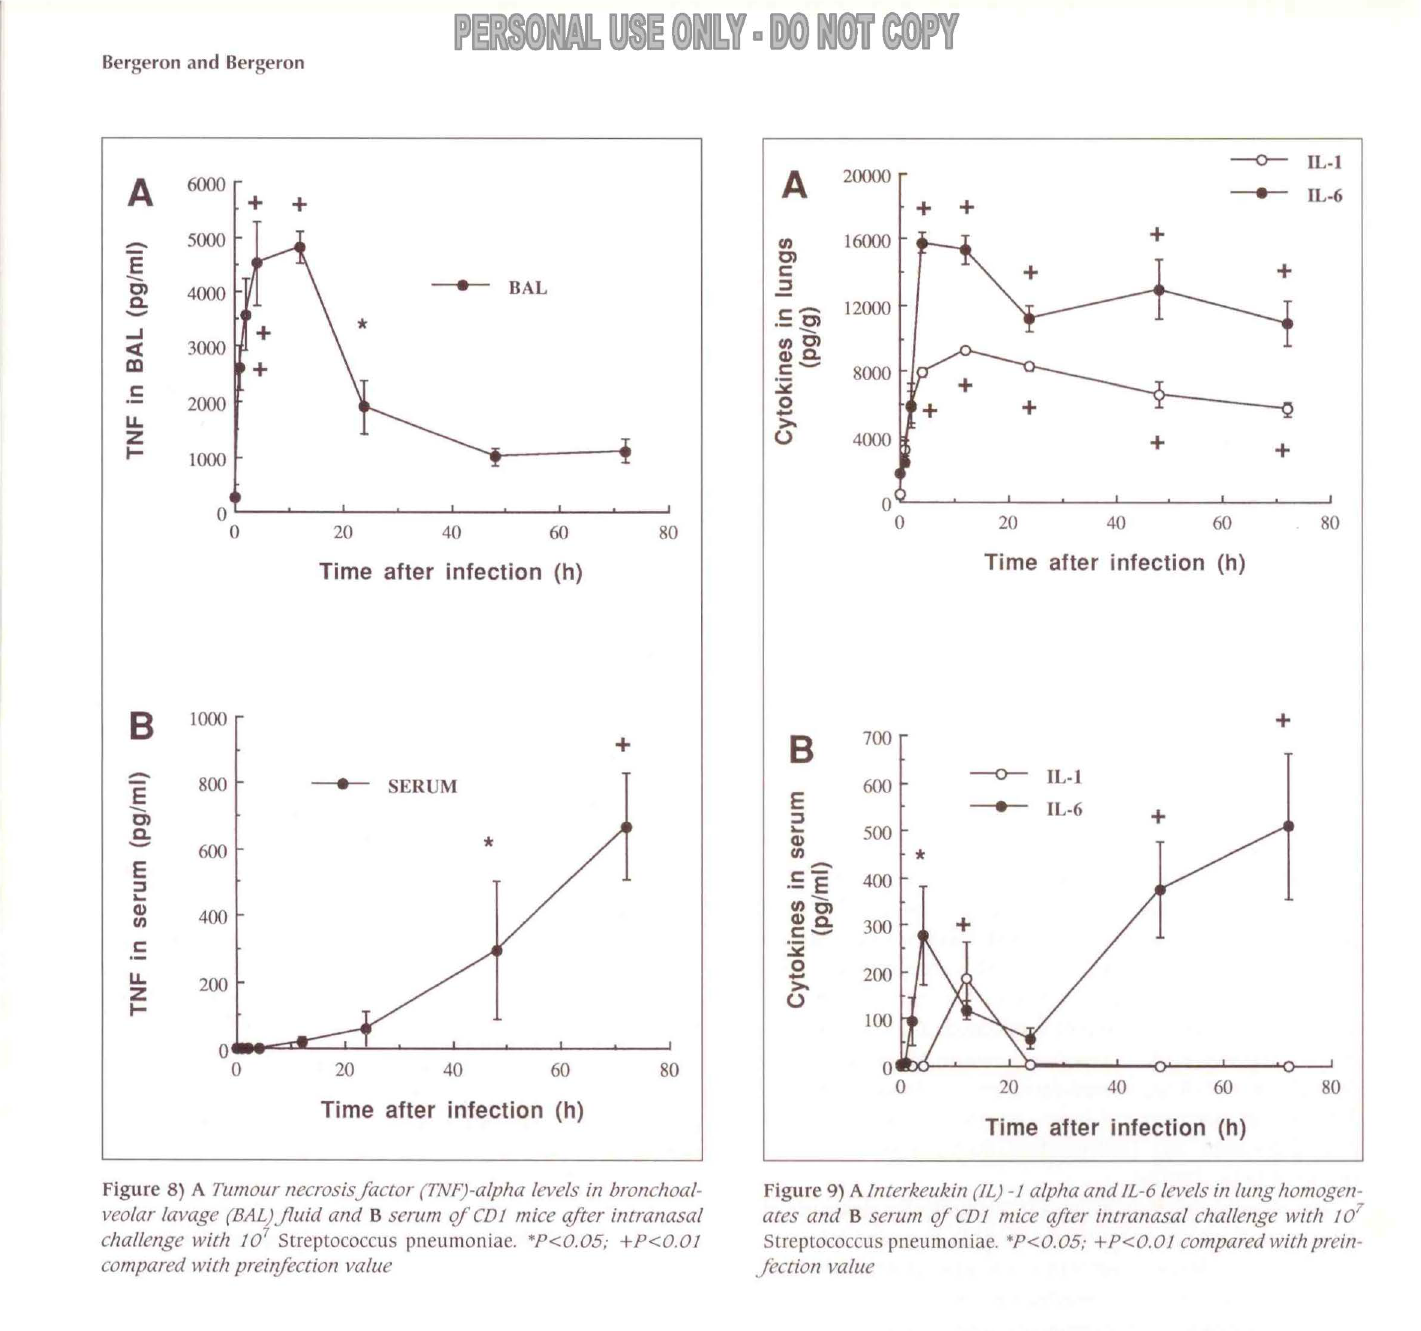
Figure 9) A lnterkeukin (IL)-/ alpha and IL-6 levels in lung homogen ates and B serum ef CD! mice qfter intranasal challenge with 10 7 Streptococcus pneumoniae. *P<0.05; +P<0.01 compared with prein- Jection value